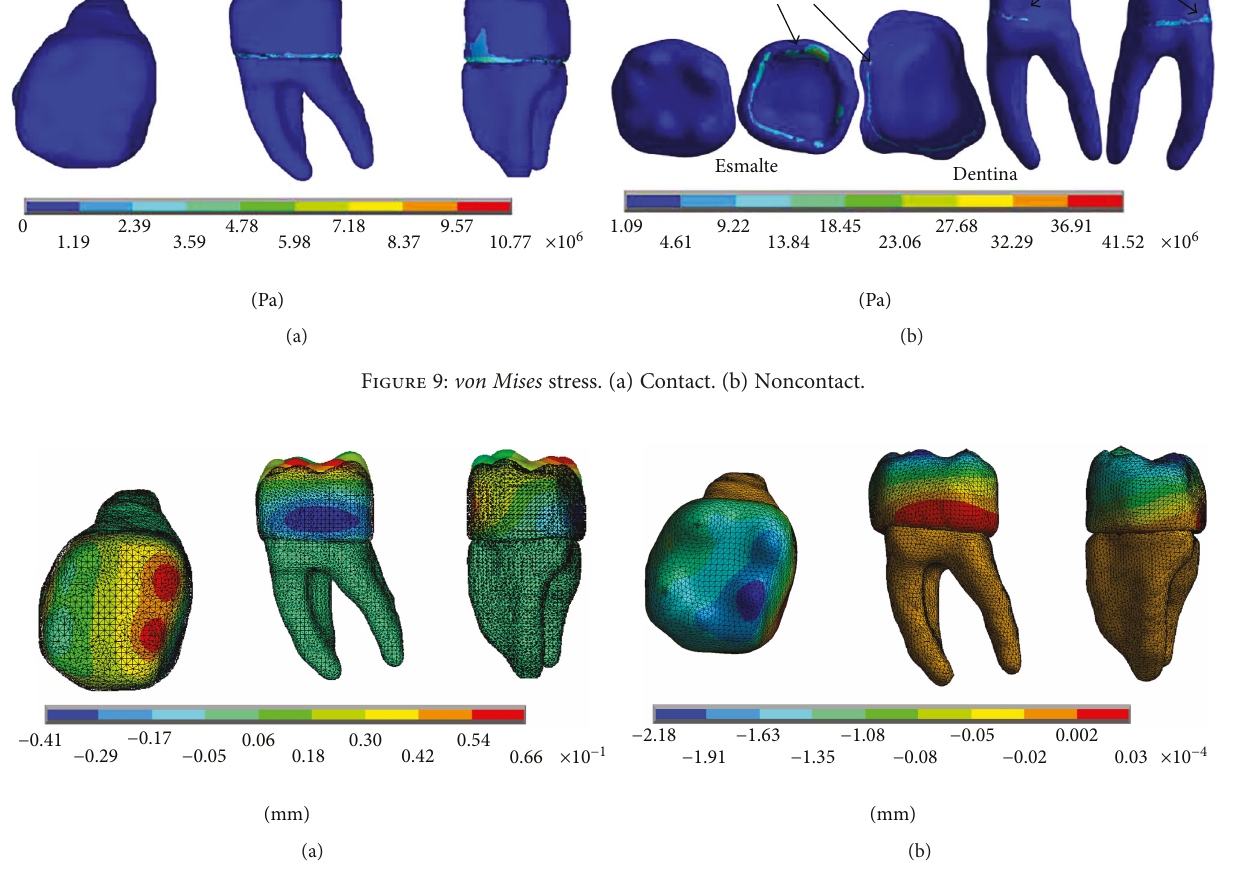
Figure 10: Displacements in the x -axis. (a) Noncontact. (b) Contact.